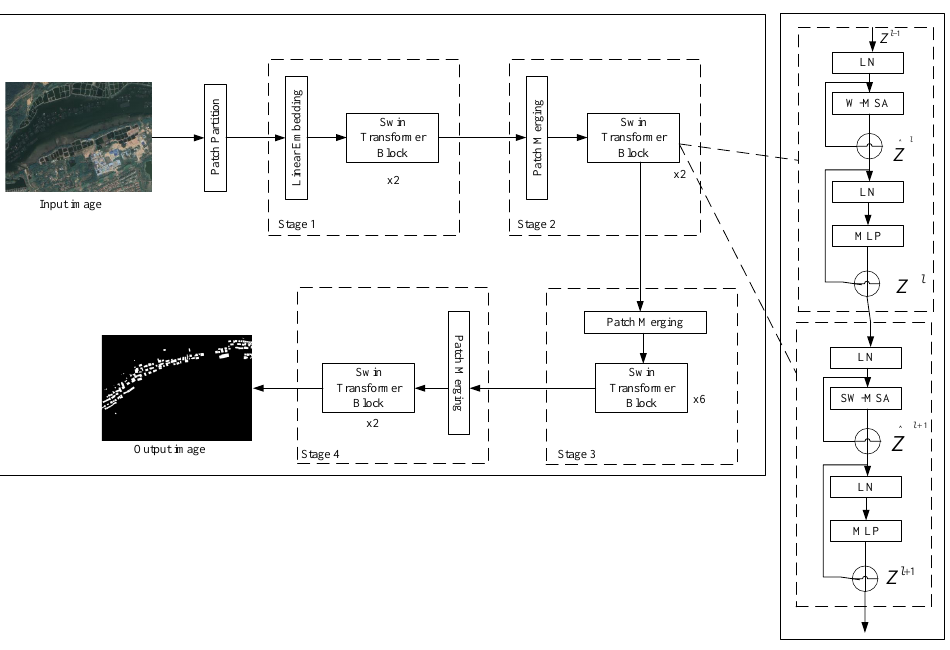
Figure 3. The architecture of the Swin